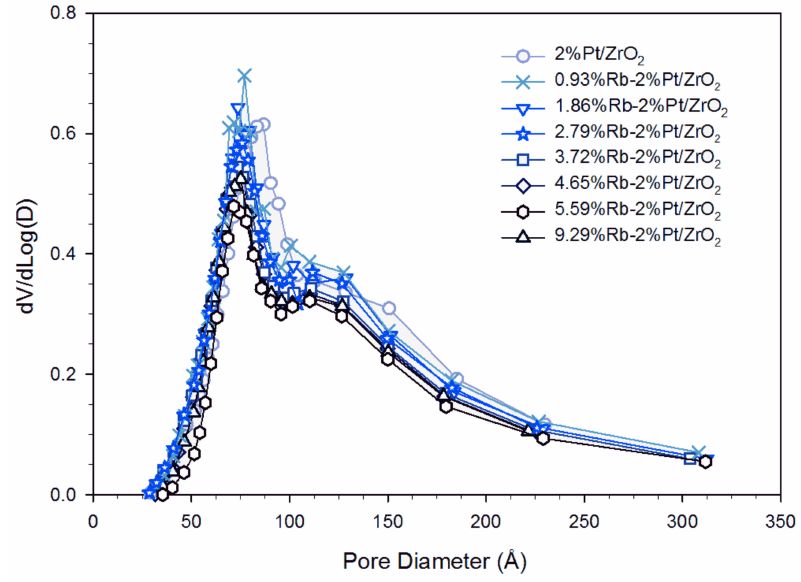
Figure 2. Pore size distribution (PSD) at different rubidium